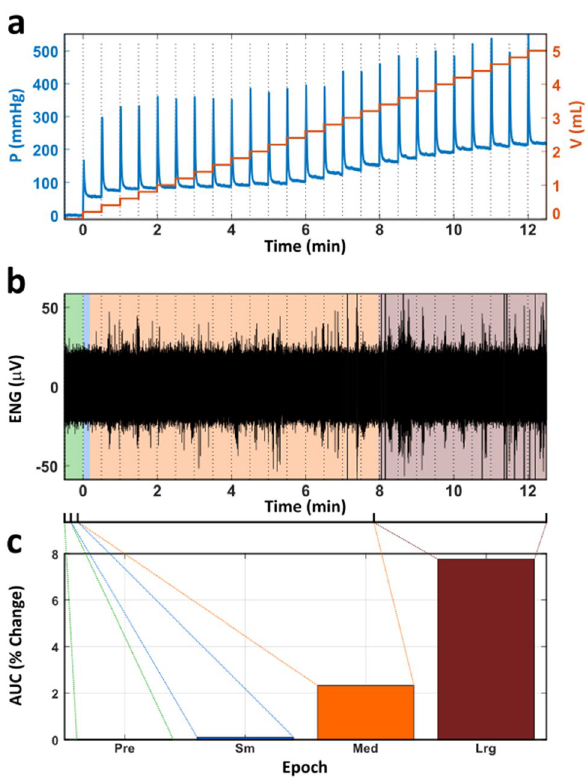
Figure 4. Example of defining dynamic epochs in one trial. ( a ) The pressure and injected volume in the intragastric balloon over the course of a trial. The distension step size was 0.2 mL. ( b ) The ENG recorded throughout the trial. ( c ) The percent change in AUC relative to pre-distension (baseline). Here, the bar height is the percent change in AUC averaged over every 5 s within the epoch (Pre: N = 30, Sm: N = 11, Med: N = 467, Lrg: N = 465). Data from animal on the standard